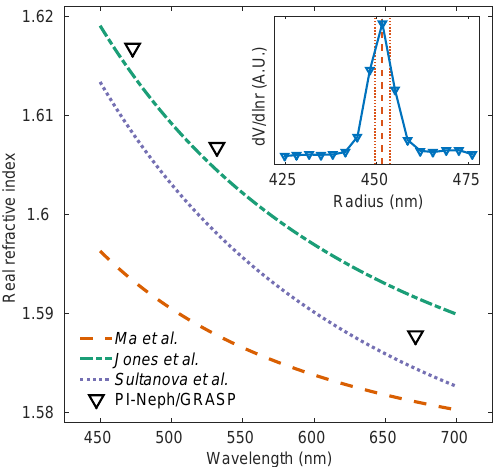
Figure 9. Retrieved real part of the refractive index for PSL spheres, alongside three previous, modern measurements of polystyrene re- fractive indices (Ma et al., 2003; Jones et al., 2013; Sultanova et al., 2003). The subplot shows the retrieved size distribution (blue) along side the manufacturer’s specified central radius (red dashes) and FW67 (red dots).